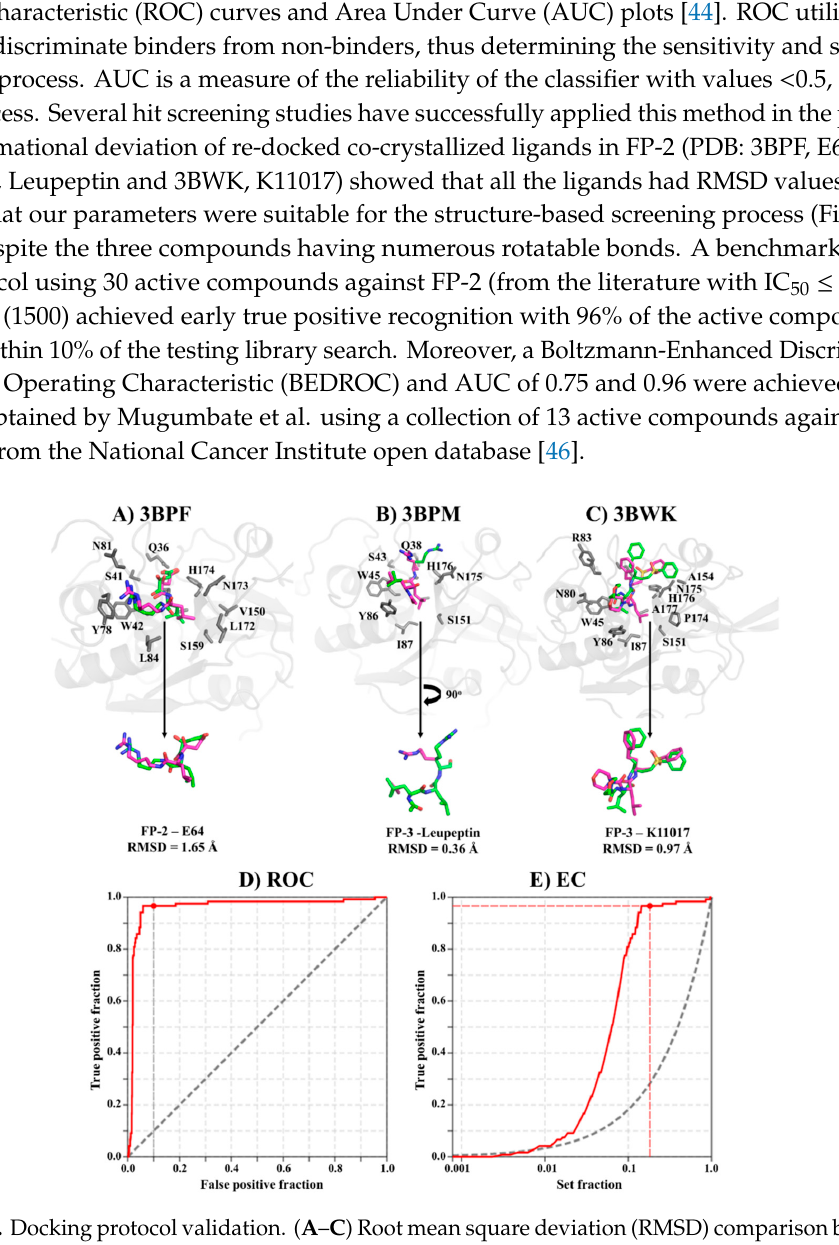
Figure 2. Docking protocol validation. ( A – C ) Root mean square deviation (RMSD) comparison between crystallographic ligand pose (pink) and the lowest energy redocked conformation (green) for E64, Leupeptin and K11017 in FP-2 and FP-3. Benchmarking result of our docking process as shown by ( D ) Receiver Operating Characteristic (ROC) and ( E ) an enrichment curve using a library of active compounds against FP-2 and their